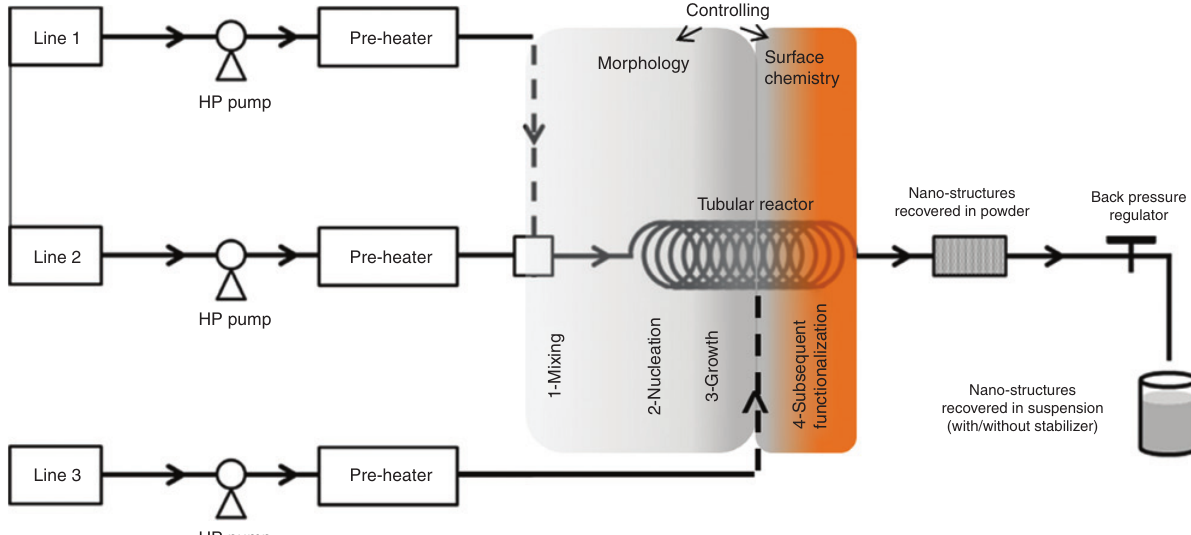
Figure 15: General sketch of CSFS with control over nucleation, growth, and subsequent functionalization steps. Reprinted with